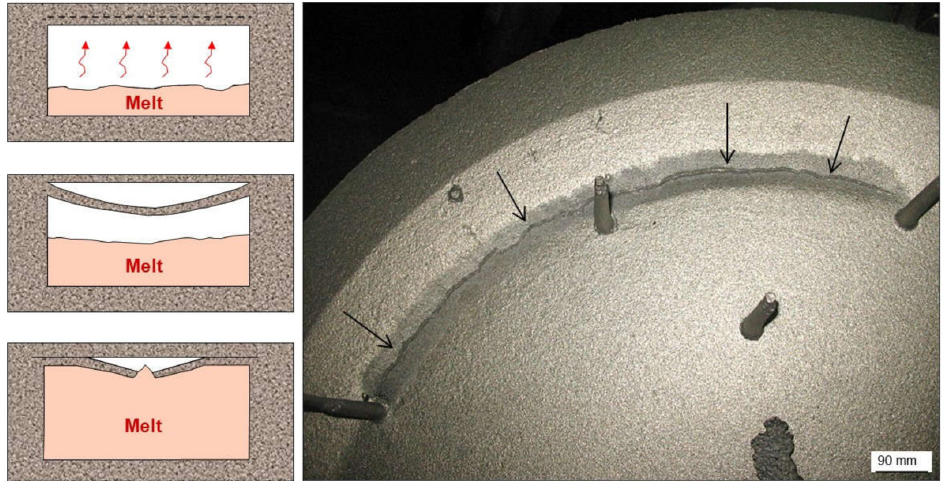
Figure 25. Schematic of a buckle formation ( left column) and photography of a buckle formed all around a heavy-section ductile iron